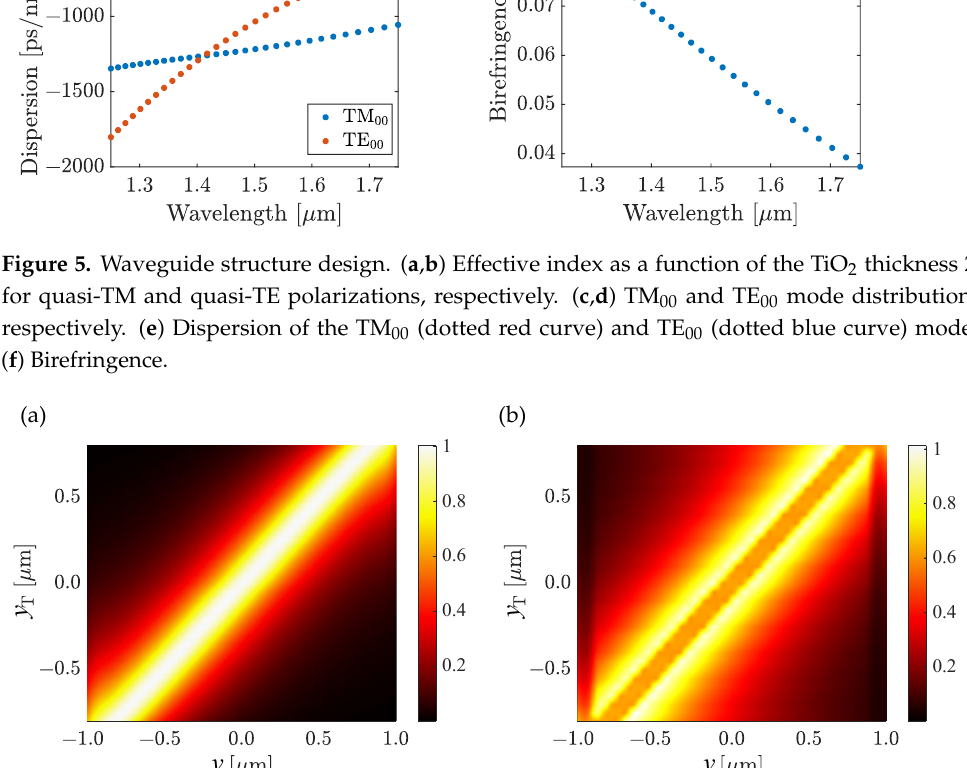
) and ( b ) TE 00 -mode profile ( of the trench. | 𝐸𝐸 𝑥𝑥 | 𝑦𝑦 T